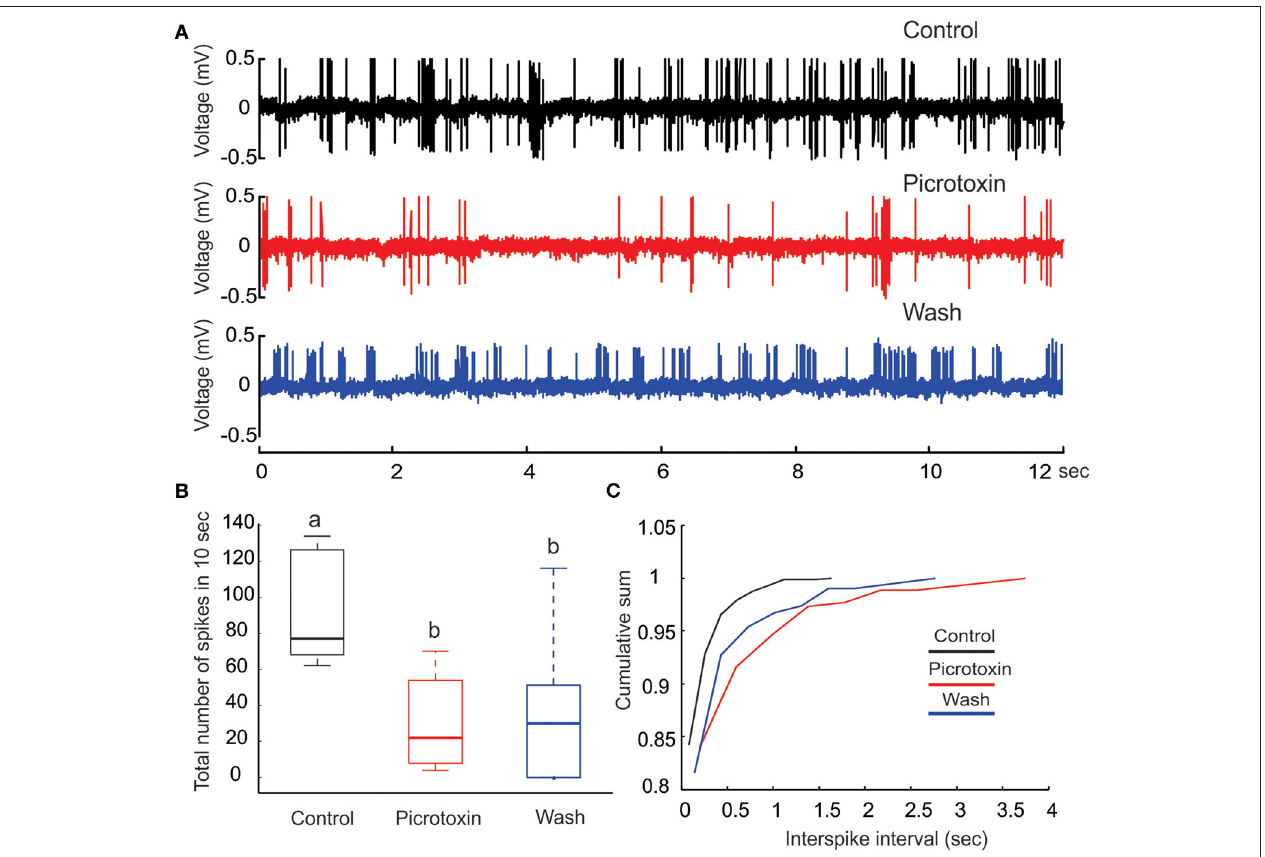
FIGURE 4 | Picrotoxin reduces PN’s spontaneous activities. (A) Juxtacellular recording traces (12s long) show a marked reduction in the number spikes due to the application of picrotoxin. (B) The reduction of number of spikes due to picrotoxin is statistically significant ( Friedman test, p < 0.01 , n = 8 ) but the effect is not fully reversible. Different letters on top of the box plots indicate statistical significance. (C) Cumulative sum of interspike intervals (ISI) shows that the picrotoxin treatment prolongs the maximal ISI to about 4s (red line) while the maximal ISI under saline control is only about 1.5s (black line). Moreover, nearly all (about 98%) ISIs under saline control are less than 0.5s but about 87% of ISIs under picrotoxin are within this range. Saline wash produces a pattern that is between the drug treatment and control (blue